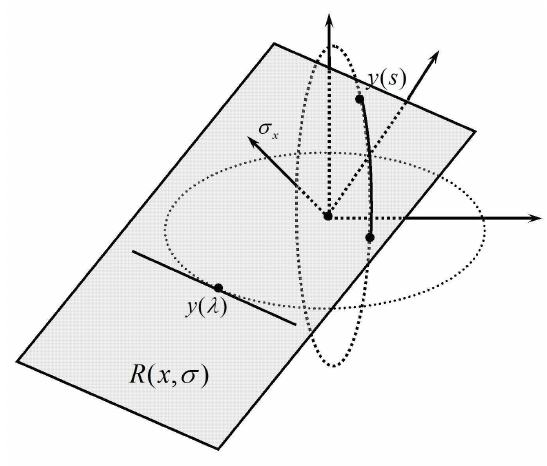
Figure 2. The filtering plane is shown, which is tangent to one of circular trajectories and is perpendicular to σ x